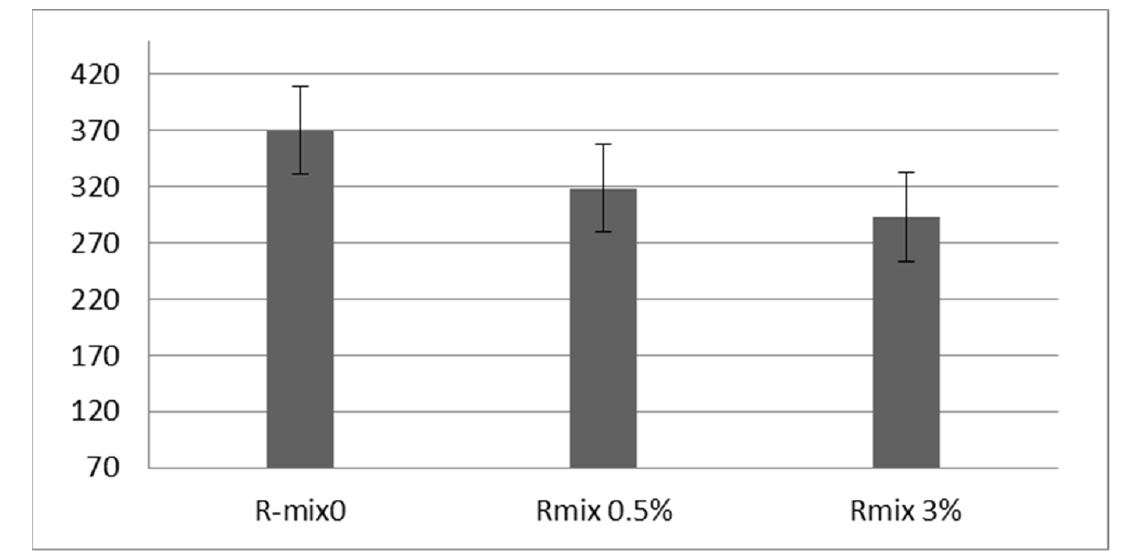
Figure 15. Flow Number Results . Figure 15.